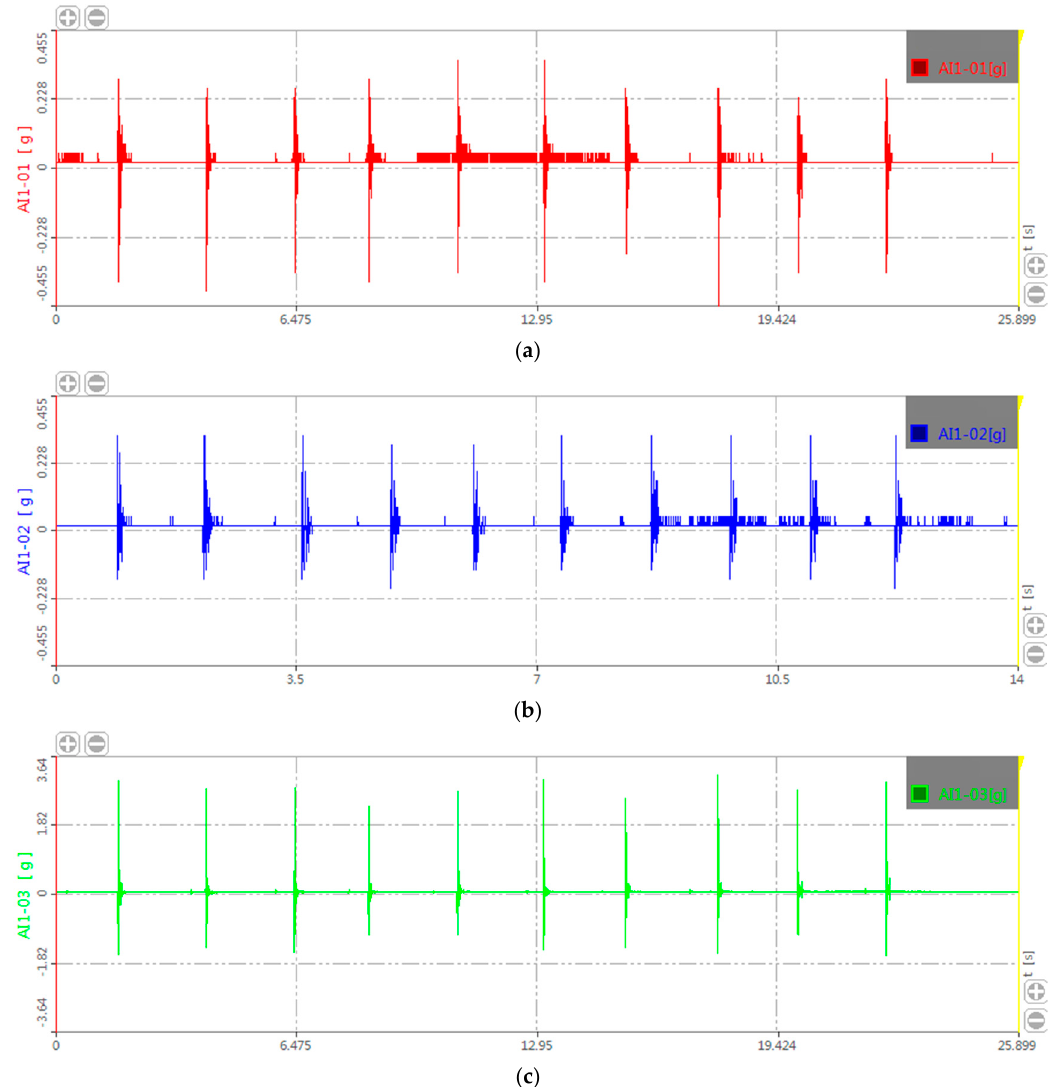
Figure 4. Measured acceleration wave curves. ( a ) Acceleration of the X-direction; ( b ) Acceleration of the Y-direction; ( c ) Acceleration of the Z-direction. Table 4. Peak value of acceleration under different test conditions. (Unit: g).